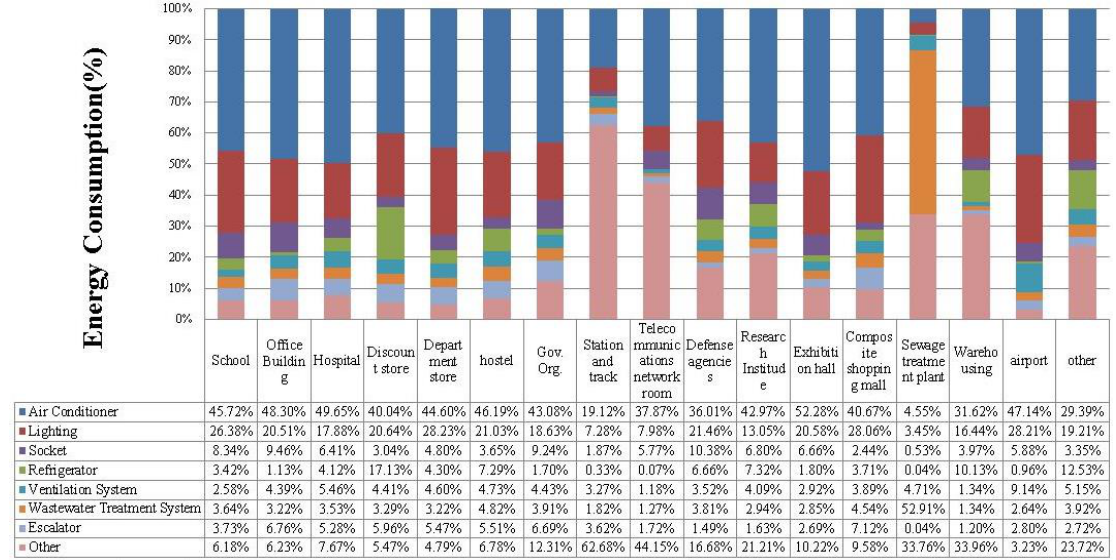
Figure 1. Energy consumption by various electrical devices in relation to type of building [1].